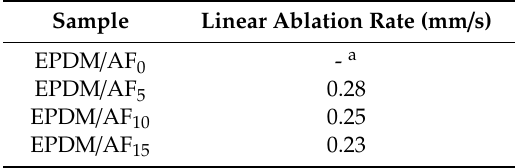
Table 8. Linear ablation rate of ceramifiable EPDM